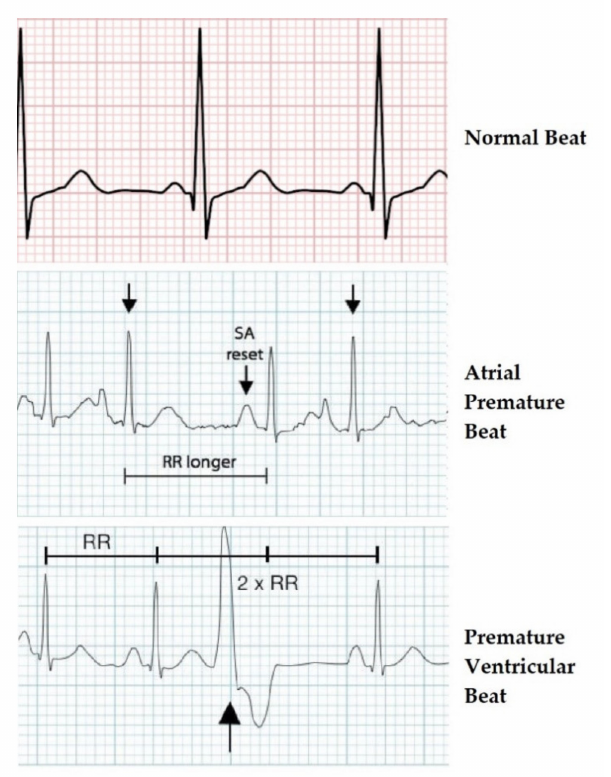
Figure 2. ECG waveforms of the three heartbeat